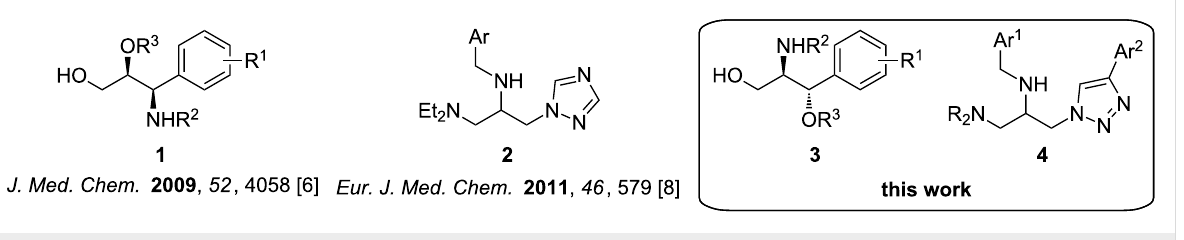
Figure 1: Functionalized aminopropanes as potential antimalarial